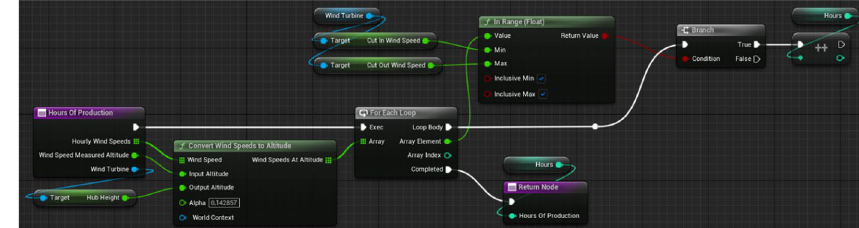
Fig. 13 Calculate the number of hours with